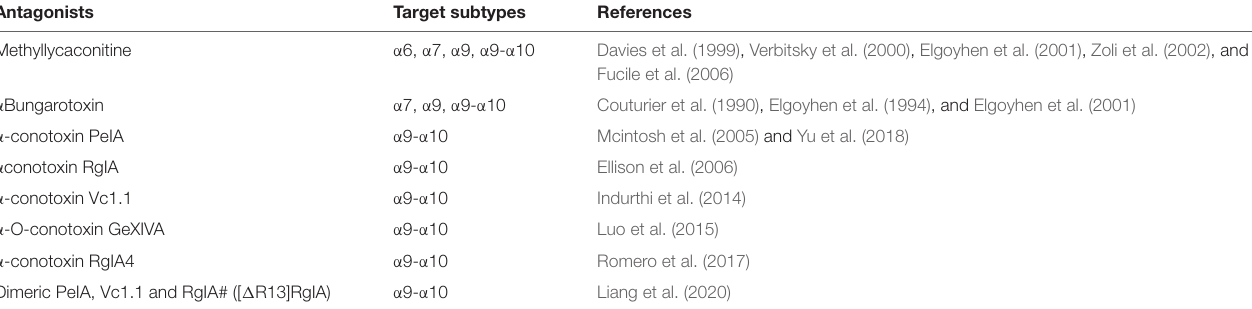
TABLE 1 | Alkaloid and peptidic antagonists targeting α 9-containing